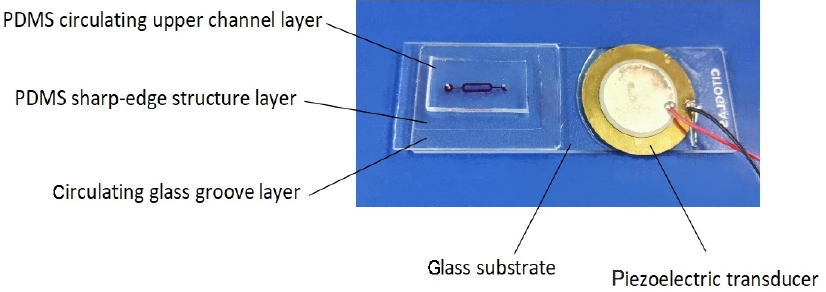
Figure 5. Photograph of the acoustic micropump.